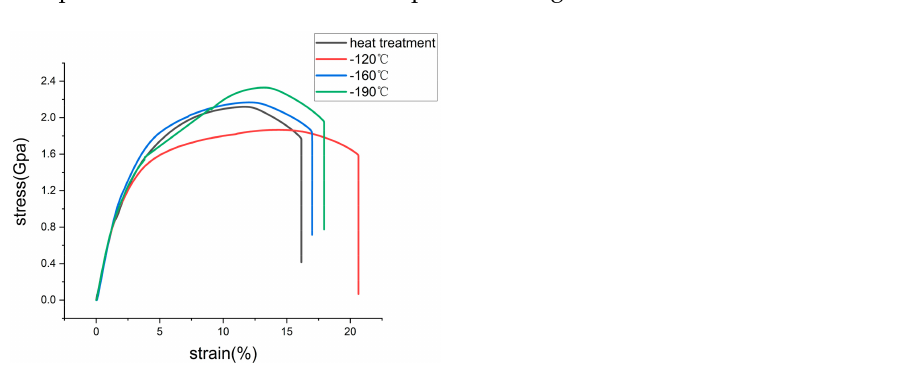
Figure 11. Hydrogen sulfide stress corrosion stress–strain curve of 42CrMo alloy steel at different cryogenic temperatures.